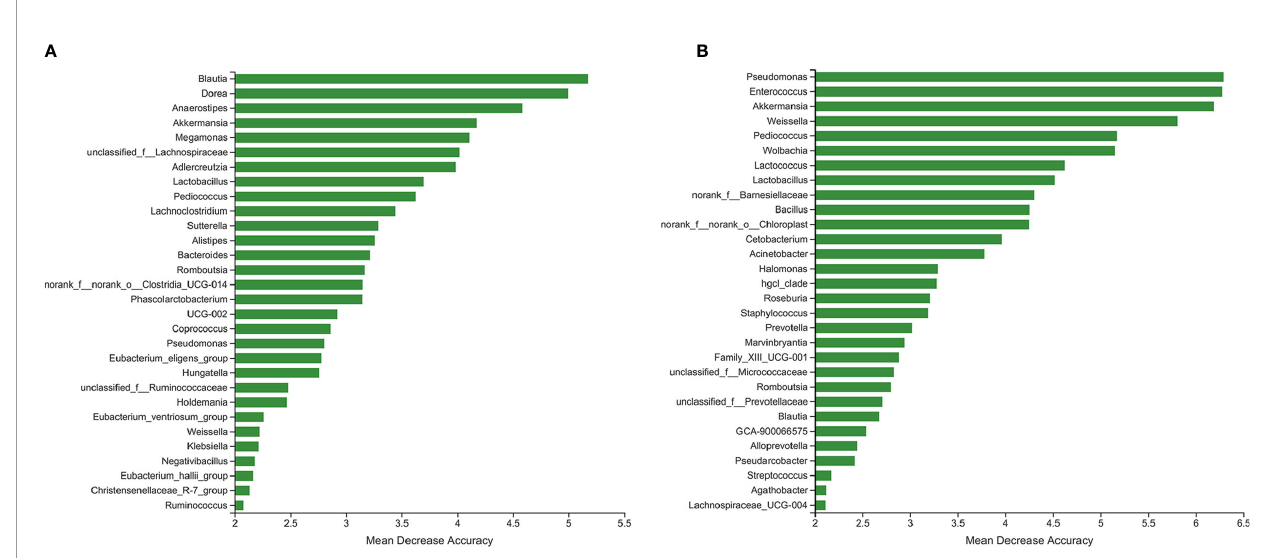
FIGURE 5 | The top 30 genera with great importance in distinguishing primary aldosteronism (PA) patients from (A) healthy controls and (B) primary hypertension